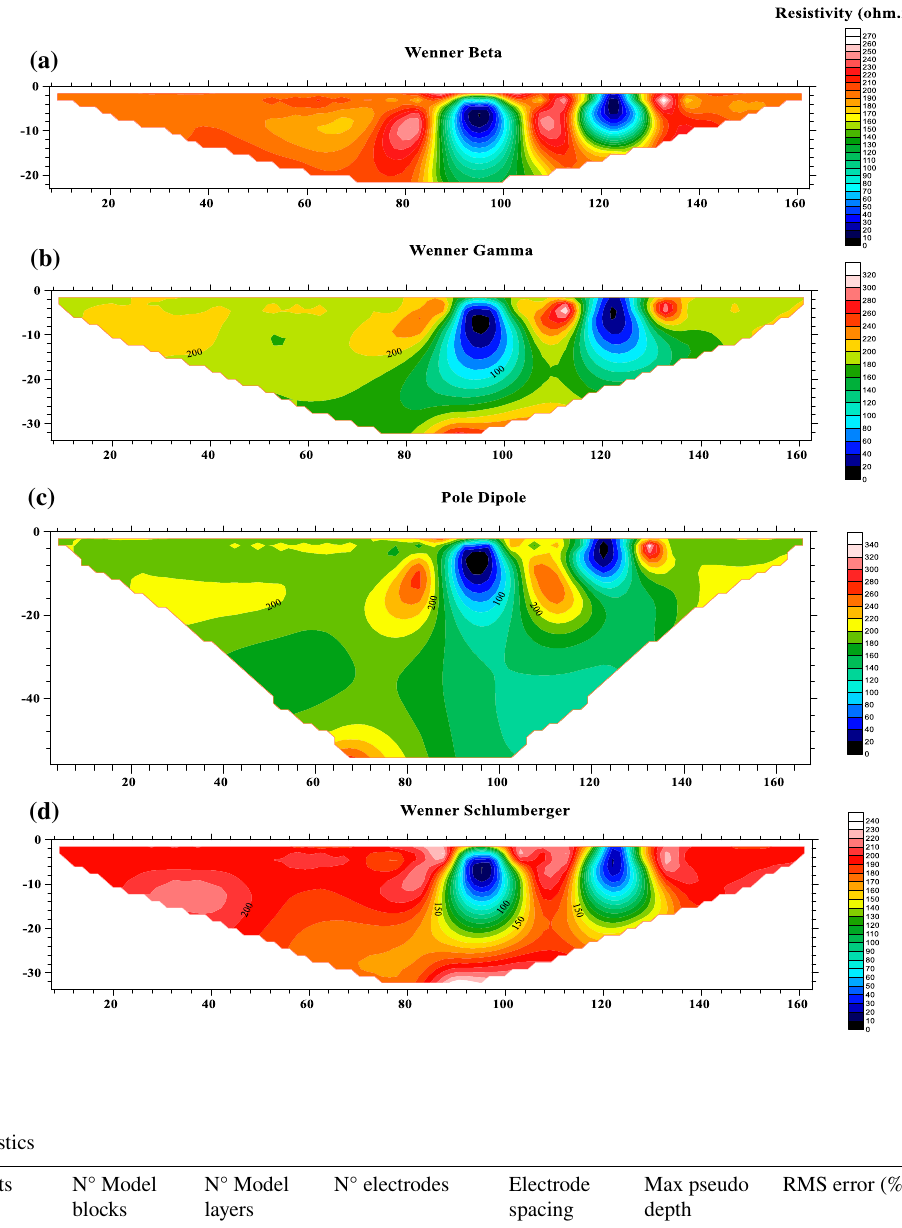
Fig. 5 Synthetic response of the synthetic model using conven- tional electric arrays, a Wenner